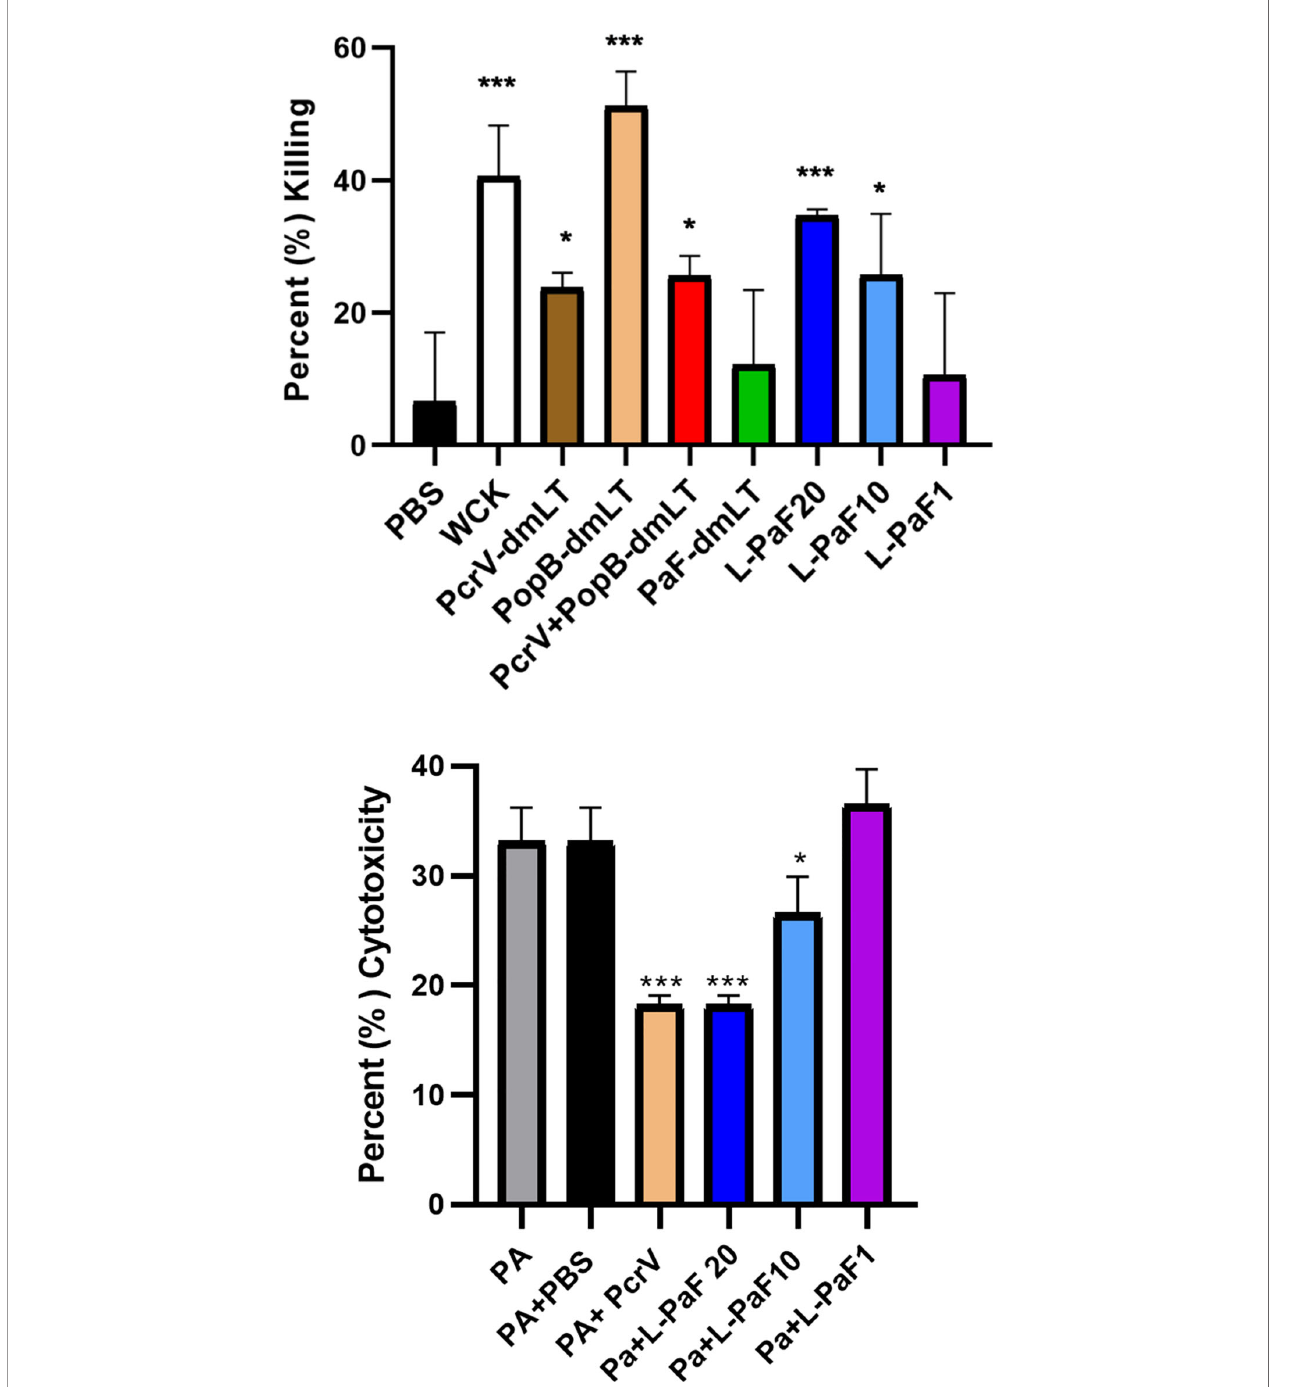
FIGURE 3 | Functional activity of serum samples. Top [opsonophagocytic killing (OPK) activity]: Sera from each vaccinated mouse group (5 µl/mouse) were tested for their OPK activity after heat-inactivation of complement. The sera were combined with mPA08-31 and J774A.1 cells at an MOI of 0.1. WCK represent sera from mice vaccinated with the killed, whole-cell Pa strain mPA08-31. Killing was determined using (T 0 -T 30 )/T 0 x100. This is a representative experiment of quadruplicates for each sample. ***p < 0.005 and *p < 0.01 for respective groups were compared to PBS using a two-way ANOVA. Bottom (Cytotoxicity inhibition): A549 cells were seeded in 96 well plates (10 4 cells/well) and incubated with serum treated PA15808959 at an MOI of 10 for 4 h. Cytotoxicity was calculated as described in Methods. Groups on x-axis are: PA, PA15808959 alone with no serum added; PA+PBS, PA15808959 with PBS vaccinated mouse serum; PA+PcrV, PA15808959 with PcrV vaccinated mouse serum; PA+L-PaF20, PA15808959 with 20 µg LTA1-GSAAS-PaF (L-PaF) vaccinated mouse serum; PA+L-PaF10, PA15808959 with 10 µg L-PaF vaccinated mouse serum; and PA+L-PaF1, PA15808959 with 1 µg L-PaF vaccinated mouse serum. Signi fi cance was calculated by comparing PA only with other groups using two-way ANOVA. *p < 0.05; **p < 0.01; ***p <